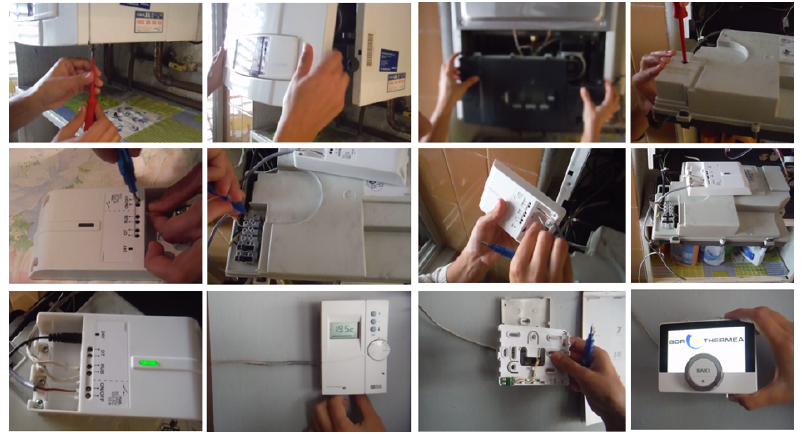
Figure 4. Pictures of the installation of the smart thermostat (BAXI CONNECT) in one of the case study households. The top row shows the removal of the front cover of the boiler. The middle row shows the connection with the gateway. The bottom row shows the new smart thermostat